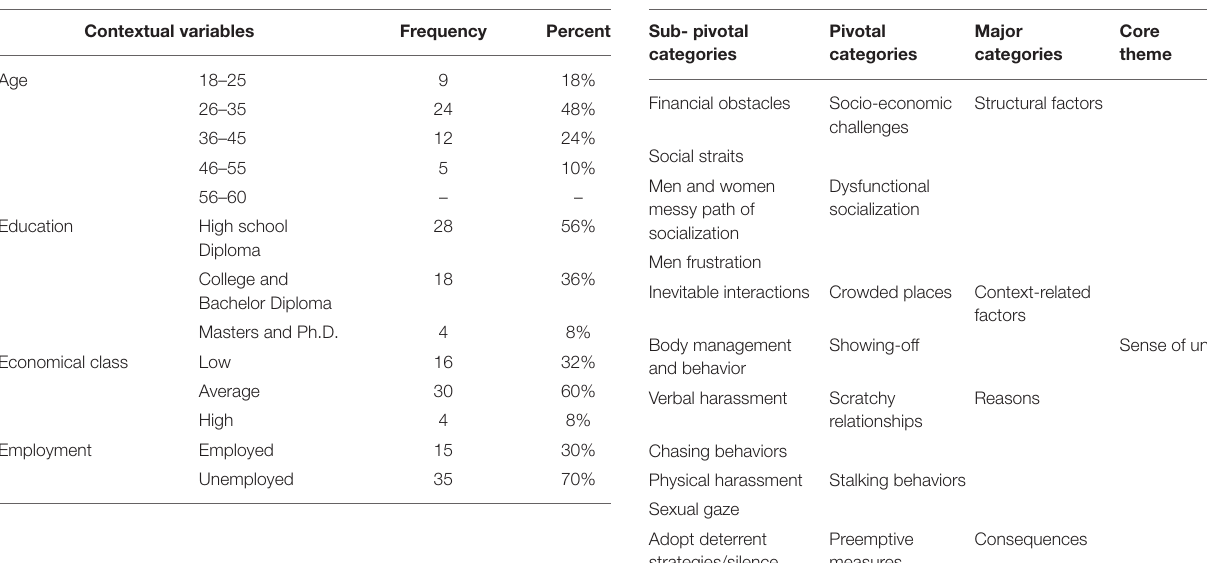
TABLE 1 | Background of